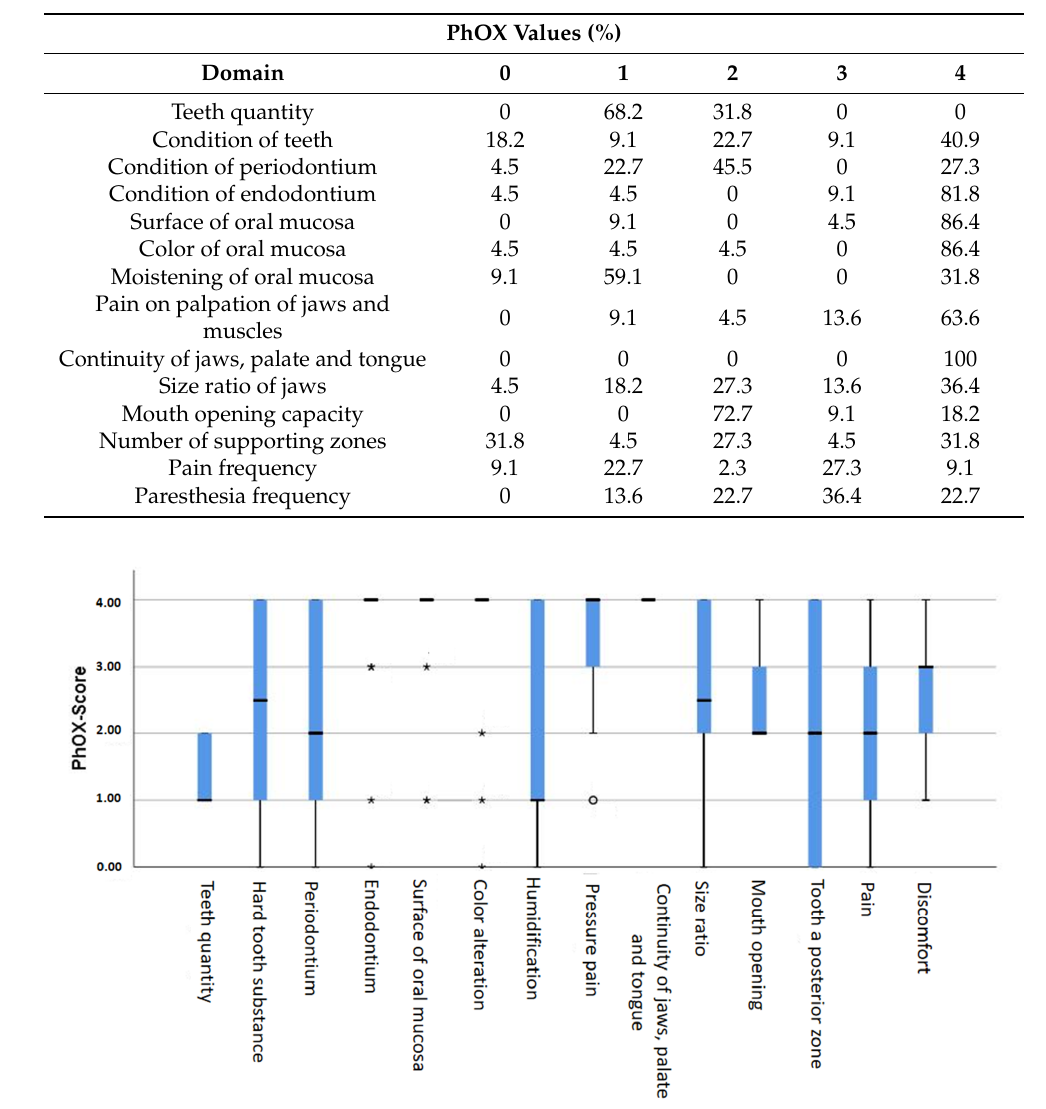
Table 3. Total PhOX values per item given by the participants (expressed as percentages).